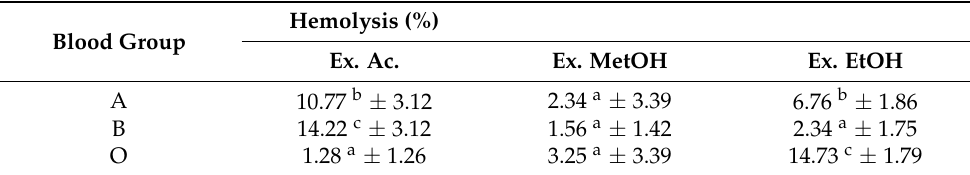
Table 3. Effect of the direct hemolysis from N. incerta extracts on different ABO blood groups. Hemolysis (%) Blood Group Ex. Ac. Ex. MetOH Ex. EtOH